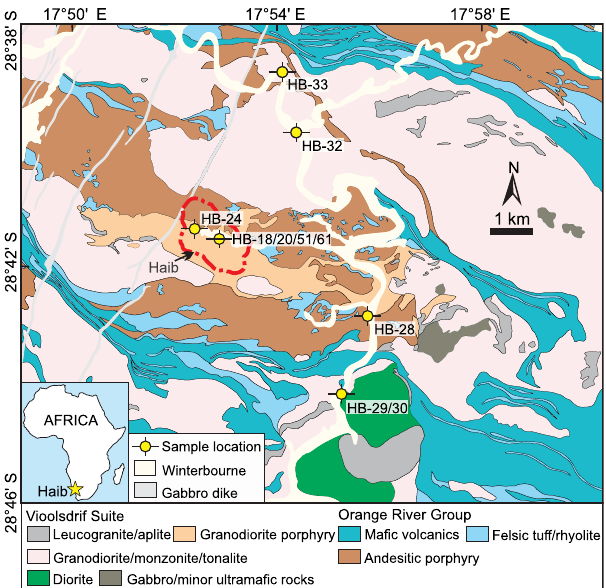
lithological units. The map is modi fi ed from ref. 83 . The red dashed line represents the de fi ned mineralization zone for Haib (report from Deep South Resources,